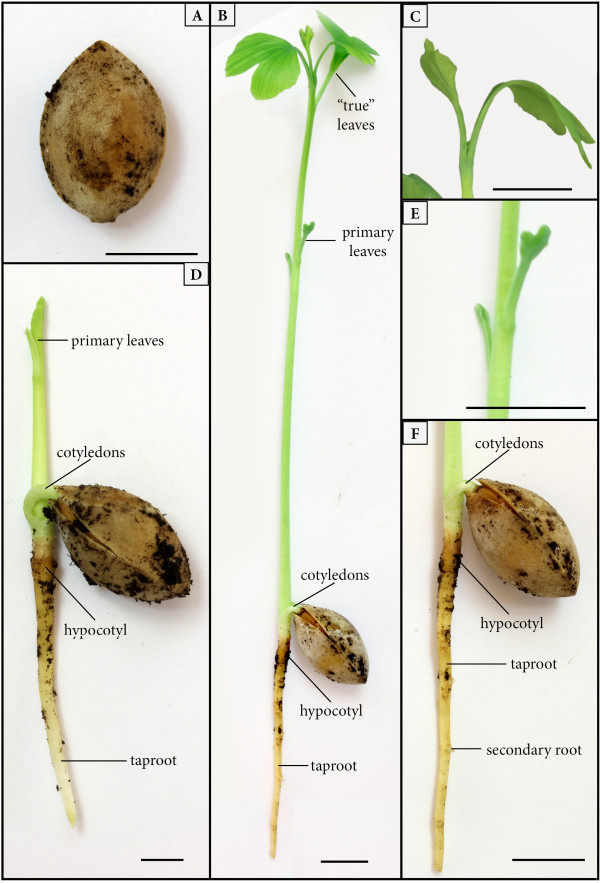
Scale bar – 1 cm. A Ginkgo biloba seed, stage 0–I. BGinkgo biloba seedling, stage IV showing taproot, first leaves and differentiated leaves. CGinkgo biloba seedling, stage IV with oppositely standing leaves. DGinkgo biloba seedling, stage II with not ramified taproot and first leaves. EGinkgo biloba seedling, stage IV (primary leaves of (B) enlarged). FGinkgo biloba, stage IV (enlarged taproot of (B) showing attachment points of secondary roots).